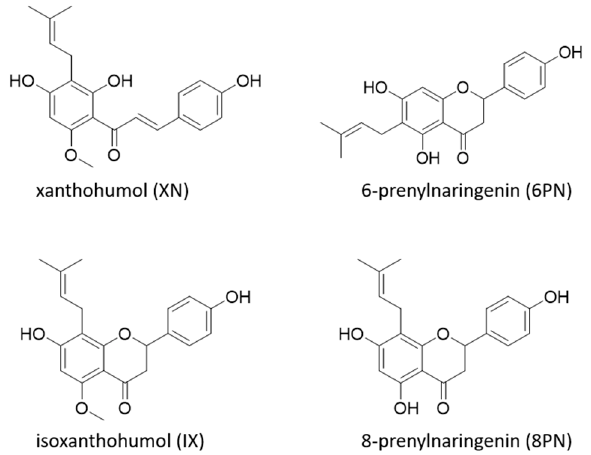
Figure 1. Structures of prenylated flavanones isoxanthohumol (IX), 8-prenylnaringenin (8PN), 6-prenylnaringenin (6PN), and the prenylated chalcone xanthohumol (XN).